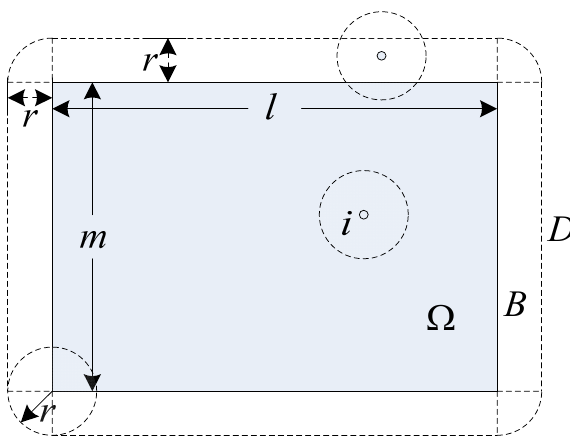
Figure 2. A sensor deployment